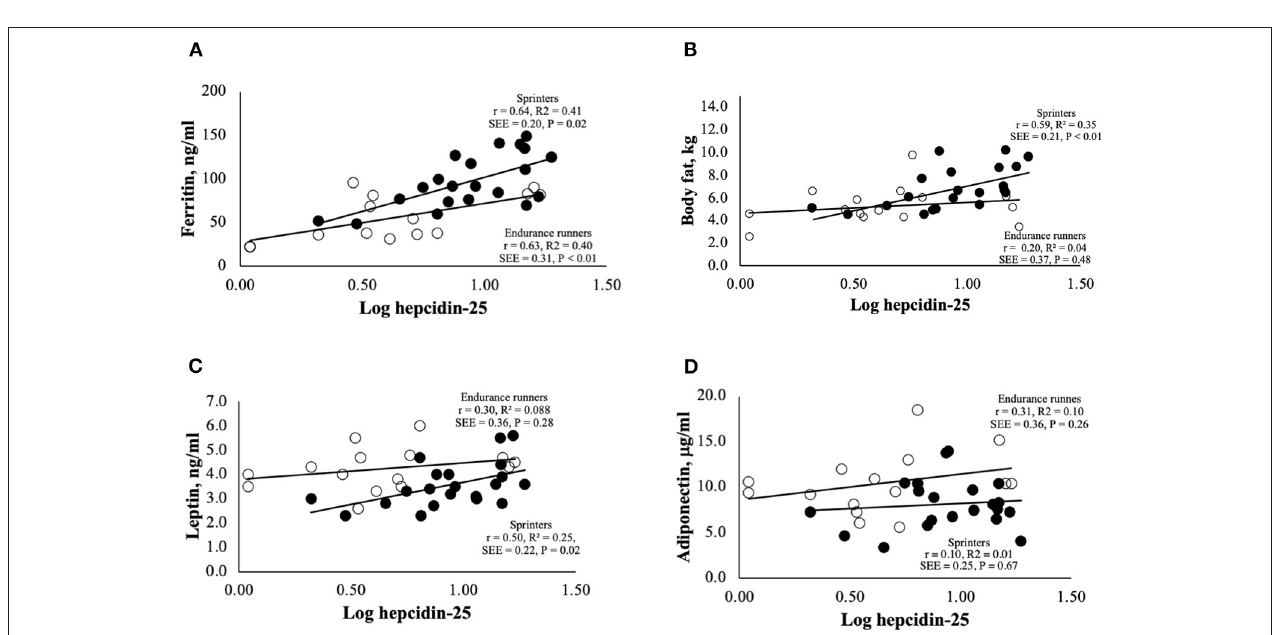
FIGURE 1 | Comparison of hepatokine and adipokine levels between endurance runners and sprinters. (A) log hepcidin-25, (B) leptin, (C) adiponectin.